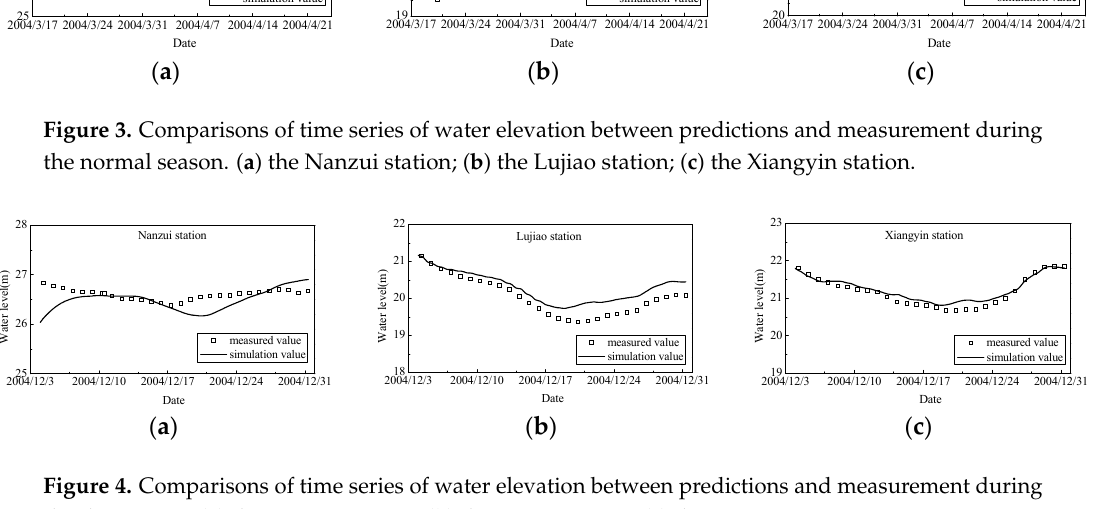
2004/3/17 2004/3/24 2004/3/31 2004/4/7 2004/4/14